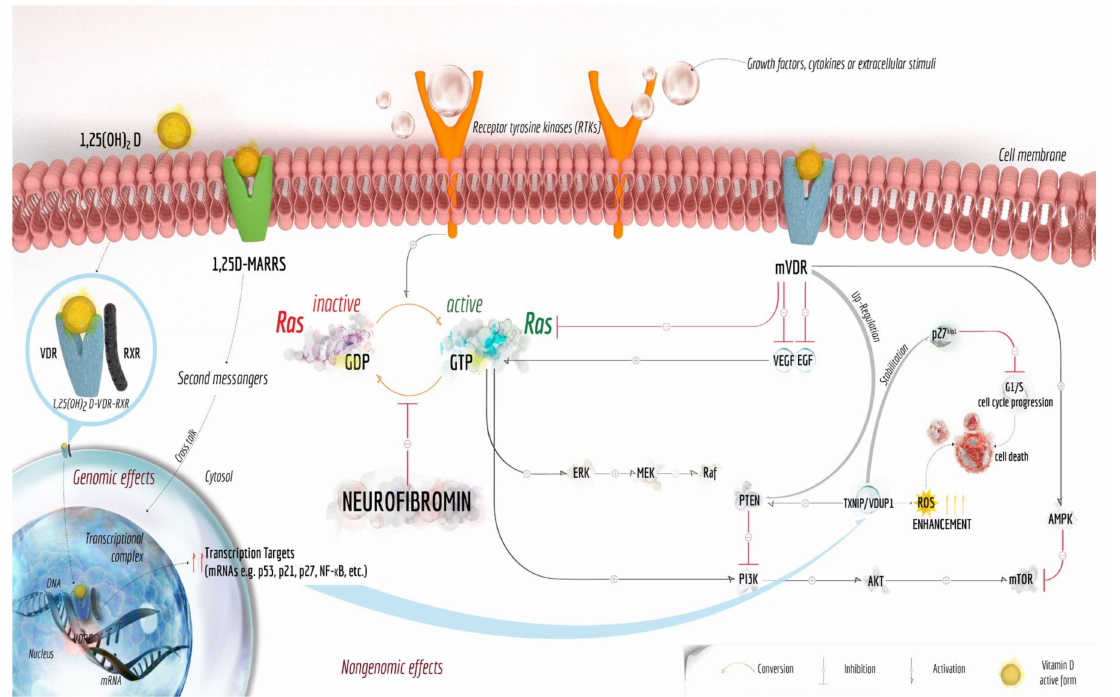
Figure 5. Multi-level regulation of vitamin D and integrated pathways with Ras-signalling controlled by neurofibromin. When 1,25(OH) 2 D binds VDRs present at the cell membrane, vitamin D influences di ff erent metabolic signalling molecules. Vitamin D inhibits the expression of both EGF and VEGF cytokines, as well as the Ras-signalling, while induces the activity of AMPK, which in turn, inhibits mTOR action. Conversely, upon binding to cytosolic VDRs, a trimeric complex with RXRs is formed, which then translocates in the nucleus and binds VDREs, finally regulating gene expression, including the transcription of VDUP1 / TXNIP mRNA. In turn, VDUP1 / TXNIP exerts several activities (L.P.